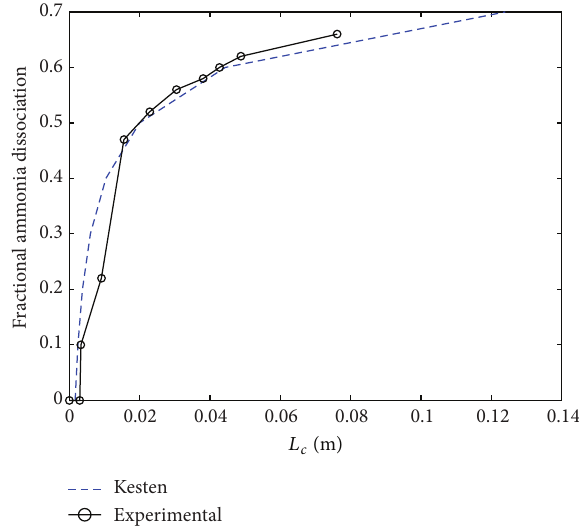
Figure 3: Variation of NH 3 decomposition percent with catalyst bed length. decomposition and Adiabatic temperature. Table 1: NH 3 NH decomposition 3 percent Adiabatic temp. (K)